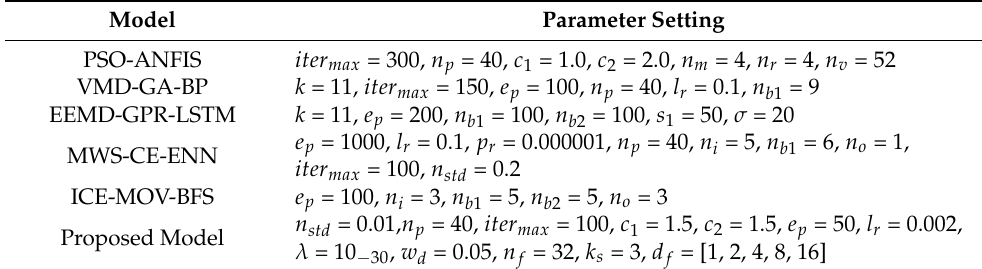
Table 2. Parameter settings of the models. Model